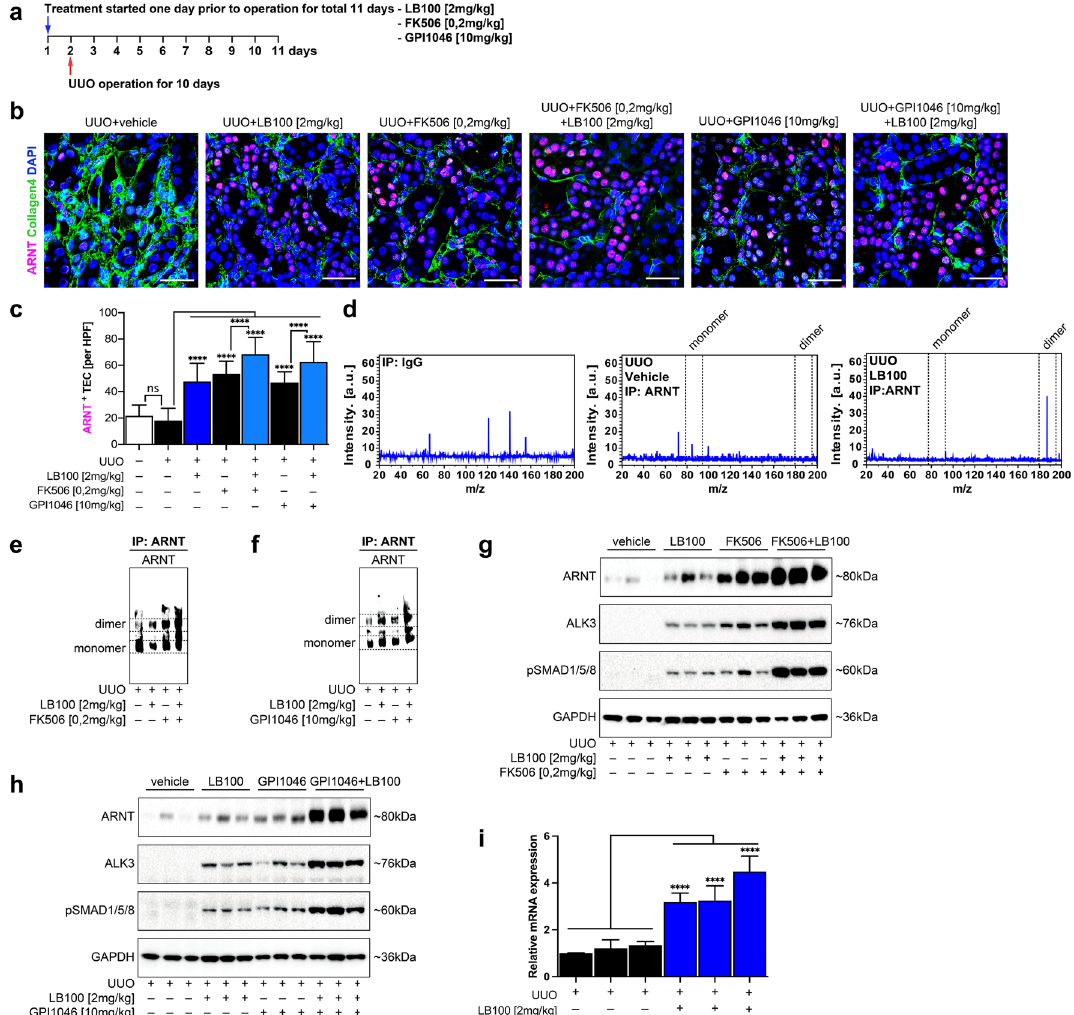
Figure 3. LB100 induces ARNT homodimerization in the obstructed mice kidney and enhances ALK3 signaling axis. ( a ) UUO challenged mice were treated with vehicle buffer (5% glucose), LB100 (2 mg/kg subcutaneously per day), FK506 (0.2 mg/kg orally per day), GPI1046 (10 mg/kg subcutaneously per day) or indicated combinations at 24 h before surgery. ( b ) Immunofluorescence labeling for ARNT (red) in fibrotic mice sections, indicating the expression of ARNT in each group. n = 6/group. Scale bars: 15 µm. ( c ) Quantitative analysis showing ARNT positive nucleus per tubule in each group. ****p < 0.0001, 1-way ANOVA versus vehicle group. Data are shown as mean ± SD. ( d ) The acquisition of the m/z of the endogenous ARNT pull down in total kidney lysates was carried out using the Rapiflex MALDI-Tissuetyper mass spectrometer equipped with smartbeam 3D laser. In the vehicle samples, the mass spectra display a weak peak with a m/z between 75 and 85 kDa representing the ARNT monomer. In contrast, the mass spectra from LB100 treated mice kidneys show a peak with m/z 190 kDa corresponding to ARNT homodimer. ( e , f ) Native protein conformation representing ARNT homodimerization upon LB100, FK506 and GPI1046 administration in total kidney lysates after endogenous ARNT pull-down. ( g , h ) Representative immunoblotting analysis of ARNT protein levels in the obstructed mice kidney in each experimental group. Increased activation of ALK3 signaling was observed in the treated groups. For immunoblotting analysis, GAPDH was used as a loading control. ( i ) qRT-PCR was used to determine the mRNA level of ALK3 in LB100 exposed obstructed mice kidneys. n = 3 in each group. Relative mRNA levels were determined after normalization to GAPDH , and data are shown as the fold change compared with vehicle group. ****p < 0.0001, 1-way ANOVA versus vehicle corresponded to the ARNT sequence in the position 74–88 and the observed fragment ions identified the serine on position 4 in the peptide (Ser77) as ARNT phosphorylation site (Fig. 2a, Supplementary Fig. S2). In sum- mary, mass spectrometric analysis of the phosphopeptide-enriched fraction identified the Ser77 to be selectively phosphorylated in LB100-induced ARNT homodimers (Fig. 2b). To assess the functional importance of phosphorylation of Ser77 in ARNT homodimer formation, we per- formed site-directed mutagenesis to change Ser77 to the negatively charged aspartic acid residue in previously established myc-tagged ARNT and EGFP-tagged ARNT constructs (Fig. 2c). We transfected cells with expression